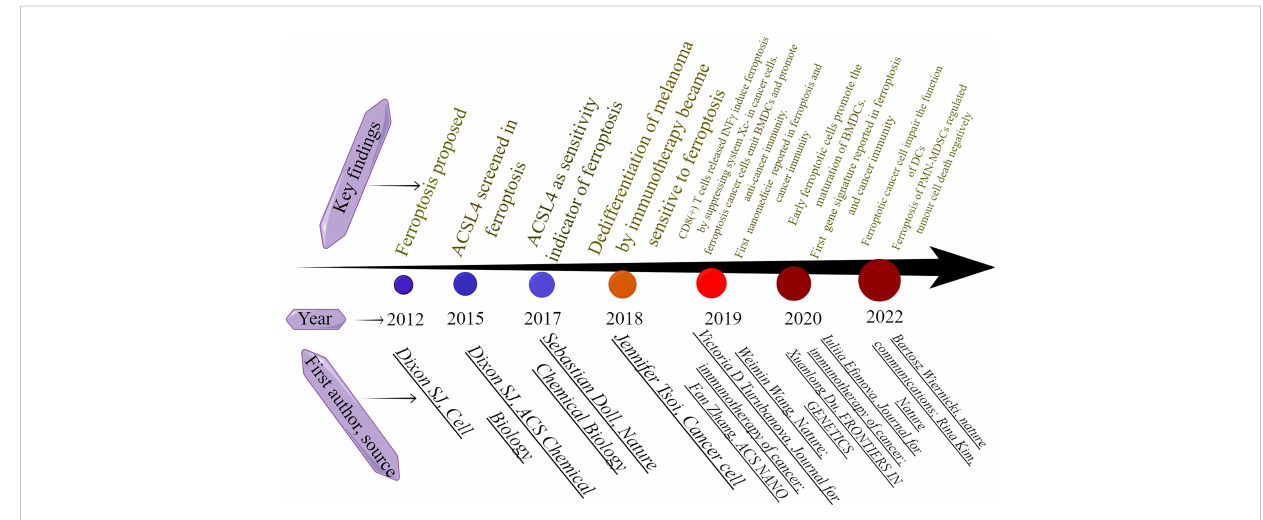
FIGURE 9 The milestones in ferroptosis and cancer immunity. This fi gure was drawn by Figdraw of HOME for